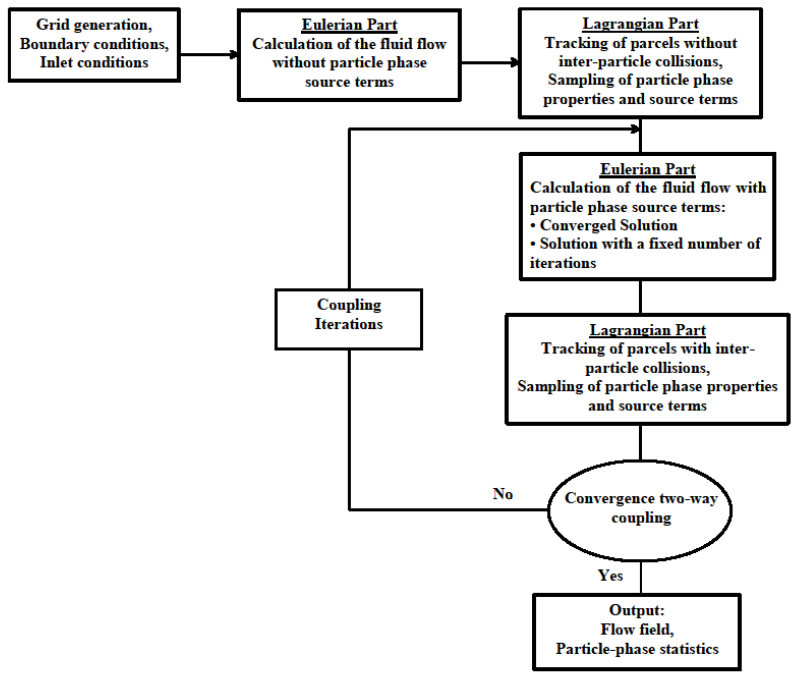
Figure 2. Procedure of numerical solution in Fluent for this problem.